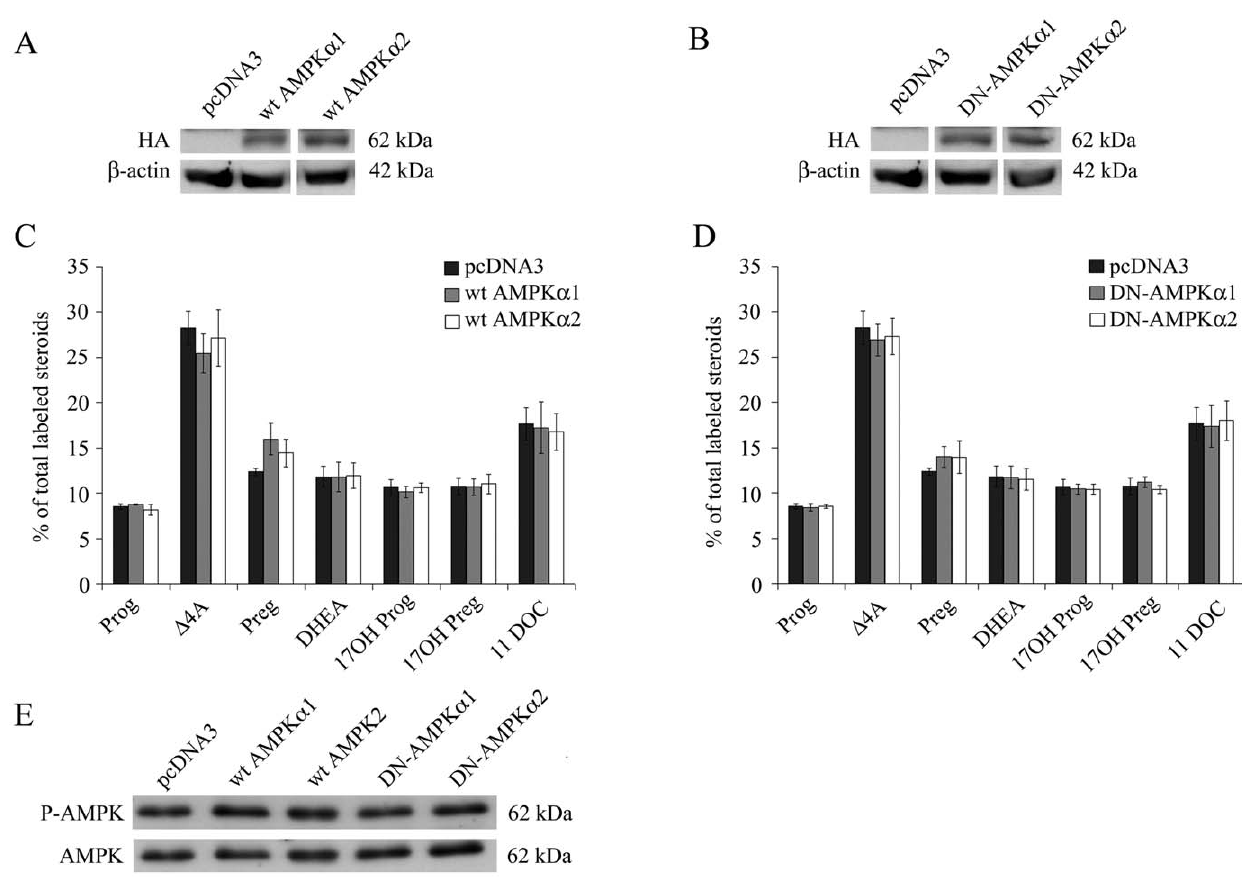
Figure 2. Effect of AMPK overexpression on steroidogenesis in NCI-H295R cells. Wild-type (wt) and dominant negative (DN) subunits of AMPK a 1 and AMPK a 2 were transiently overexpressed in NCI-H295R cells using specific expression vectors. Steroid production was analyzed by thin layer chromatography (TLC) using radiolabeled ( 3 H) pregnenolone (100,000 cpm/35-mm well) as precursor. A–B, representative Western blots showing expression of HA-tagged protein of AMPK a 1 or AMPK a 2. b -actin served as a loading control. C–D, steroid profiles of transfected NCI-H295R cells showing no effect of AMPK overexpression (C) and no effect of dominant negative AMPK a 1 or AMPK a 2 (D). Quantification of steroids on TLC was performed from two independent experiments and is given as mean 6 SEM. D 4A, androstenedione; Preg, pregnenolone; 17OH-Prog, 17 a - hydroxy-progesterone; 17OH-Preg, 17 a -hydroxypregnenolone; DHEA, dehydroepiandrosterone; 11 DOC, 11-deoxycortisol. E, Western blot showing AMPK-phosphorylation upon overexpression or blocking of alpha 1 and 2 subunits of